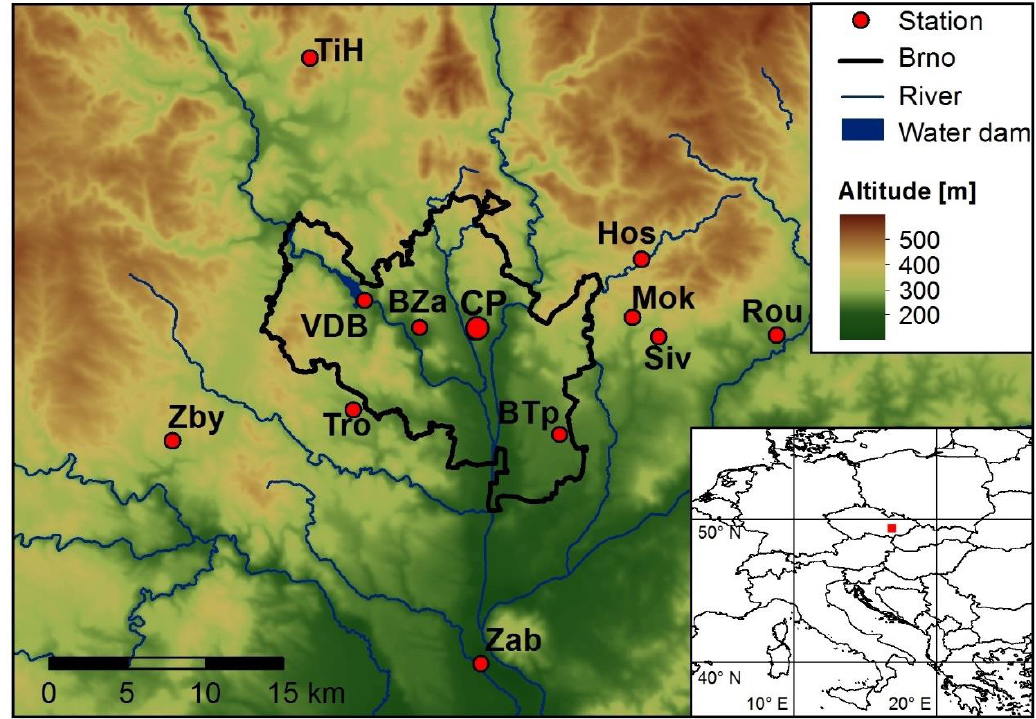
Figure 1. Spatial localization of employed meteorological stations in Brno and surrounding area; abbreviations of station names are explained in Table 1 (CP – locality Černá Pole, containing a total of three stations – Met, Dav, Arb).